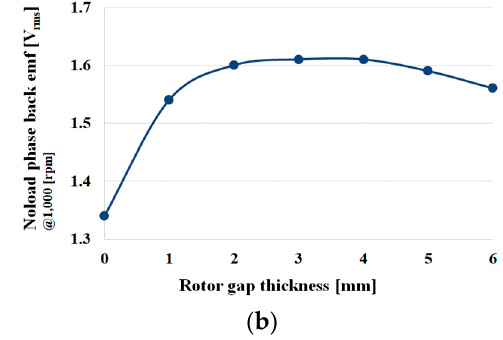
Figure 8. Back EMF graph according to rotor gap variable and rotor gap: ( a ) rotor gap variable, ( b ) back emf graph according to rotor gap.